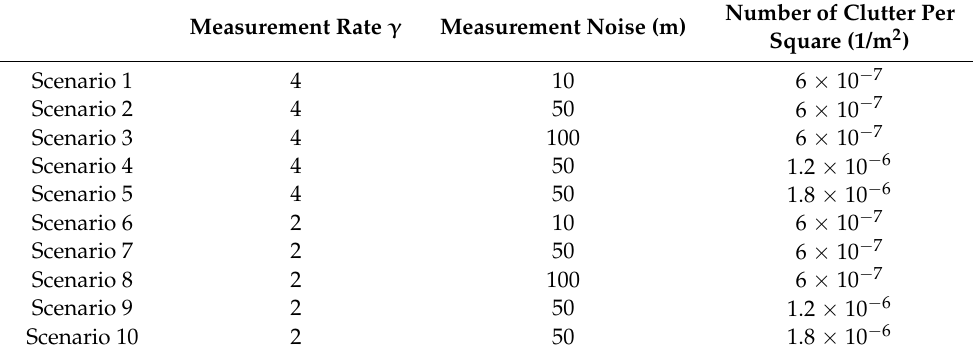
Table 1. The parameters of the